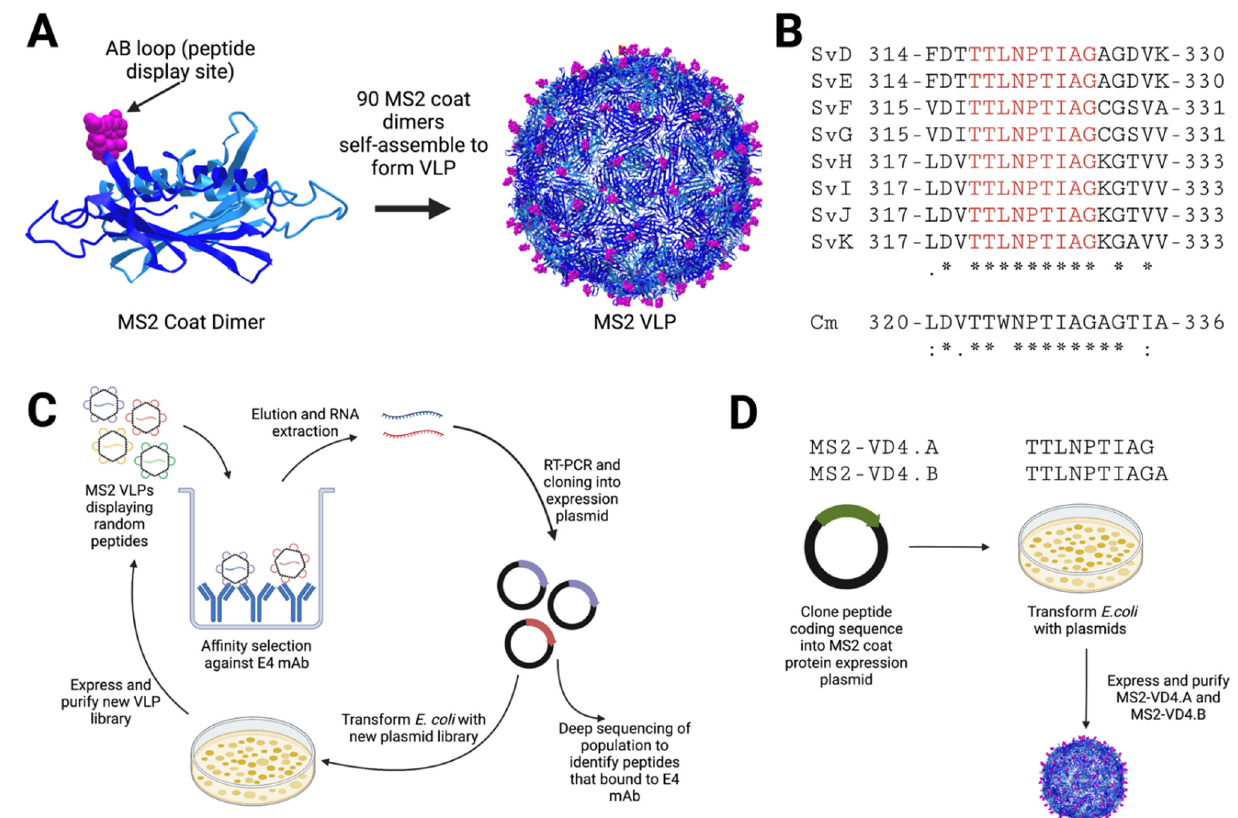
Figure 1. Schematic of MS2 bacteriophage VLP-based approaches for MOMP VD4 conserved epitope vaccine design. ( A ) MS2 bacteriophage coat protein dimers each display one foreign peptide in the surface-exposed beta-hairpin, called the AB loop. ( B ) The sequence of the VD4 core conserved epitope (TTLNPTIAG) is shown in alignment for all urogenital Ct serovars (* perfect conservation), as well as Cm. Cm alignment scores are as compared to CtsvD (shown below Cm sequence), and alignment scores of all urogenital serovars are shown below Ct SvK. ( C ) Affinity selection approach against E4 mAb. An MS2 VLP library displaying random peptides in the AB loop is panned against the E4 mAb. Bound VLPs are eluted, and encapsidated coding RNA is extracted. This is then subjected to RT-PCR and cloning into the MS2 VLP expression plasmid, which is then transformed into E. coli to produce a new VLP library that is enriched for VLPs that bind to E4 mAb. The process is then repeated for four total rounds. The RT-PCR product from the final round is then subjected to deep sequencing to identify peptides of interest that bind to E4 mAb. ( D ) Rational-design approach using display of the VD4 core conserved epitope MS2 VLPs. The coding sequences for peptides are cloned into an MS2 coat protein expression plasmid such that the peptide is displayed in the AB loop. Plasmids are then transformed into E. coli , and VLPs are expressed and purified.